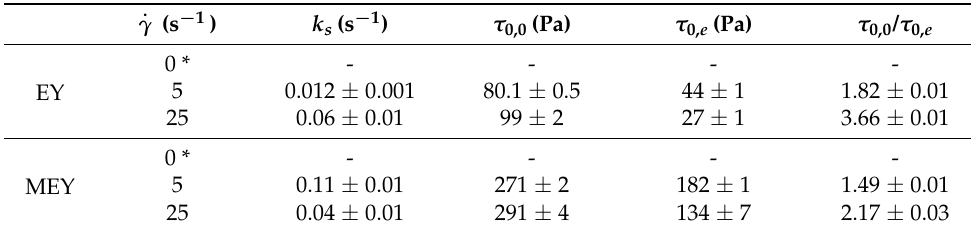
Table 1. Fitting parameters obtained from the SKM analysis of rheological data for EY and MEY emulsions, before and after shearing at 5 s − 1 and 25 s − 1 .